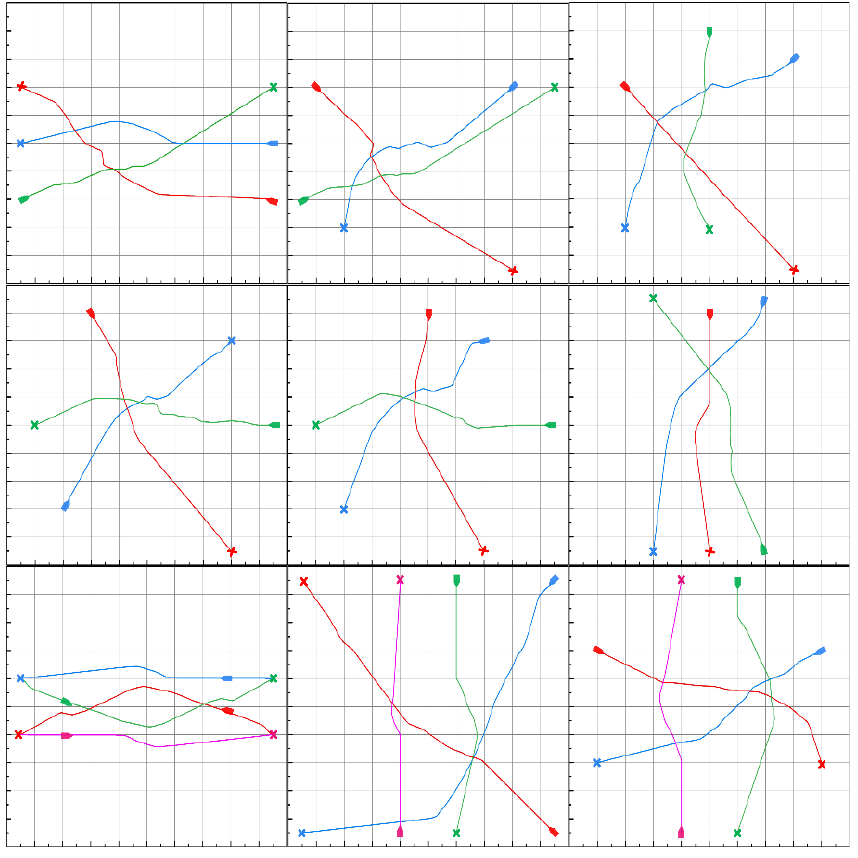
Figure 19. Additional multiple-ships encountering scenarios. (The simulation of the more multi-ship encountering scenarios).